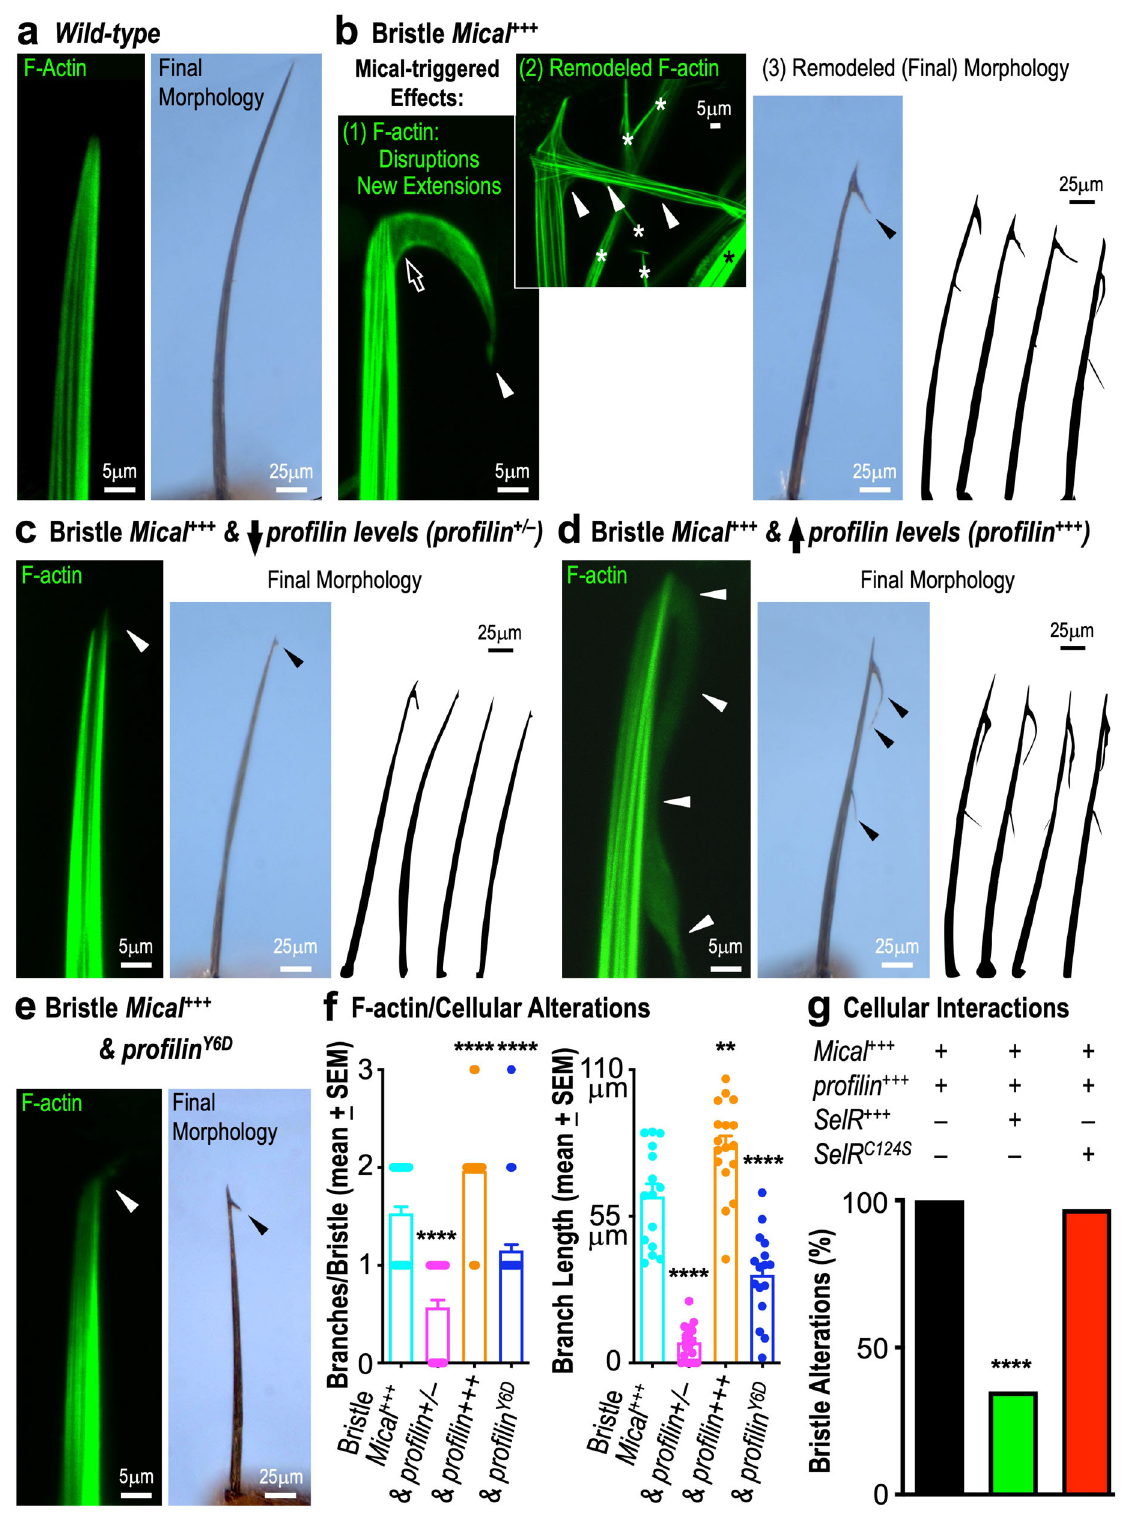
connectivity 35,41 . We therefore employed the Drosophila nervous system as a model to examine if pro fi lin and Mical also work together in vivo to direct the guidance of axons. In particular, axons assemble actin into branched (lamellopodia) and unbran- ched ( fi lopodia) structures to elongate 43,44 and they grow in a stereotypic manner, including that they respond at what